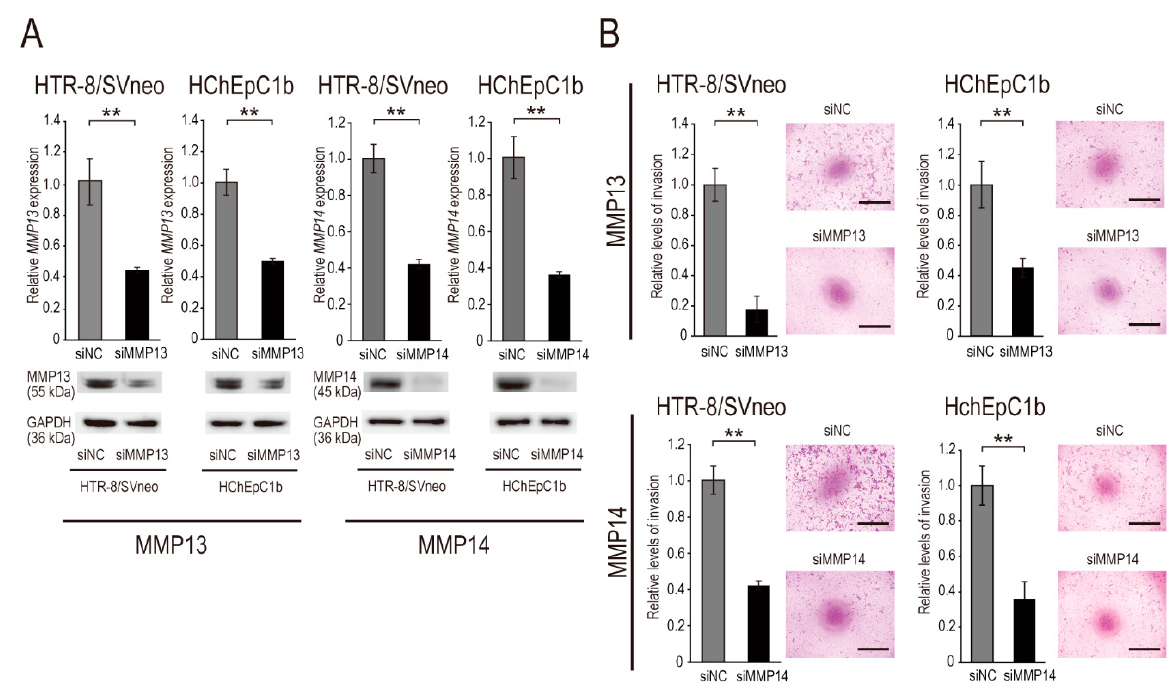
Figure 4. MMP14 and MMP13 inhibition attenuated the invasive ability of EVT cell lines. ( A ) Knockdown efficiency in EVT cell lines (HTR-8/SVneo and HChEpC1b) transfected with siMMP13 and siMMP14. MMP13 mRNA and protein (left panel), and MMP14 mRNA and protein (right panel) expression in EVT cell lines transfected with 20 nM siMMP13, siMMP14, or siNC and cultured for 24 h. Normalization in qPCR was performed using 18S; GAPDH was used as the internal control in Western blotting. ( B ) Transwell invasion assay of EVT cell lines transfected with siMMP13 and siMMP14. For the invasion assay, the number of invasive cells was expressed as a percentage of the control value, and the invasion level of siNC was set at 1.0. Data are presented as the mean ± SD of the results of three independent experiments. ** p < 0.01; Student’s t -test. Bars = 1 mm.